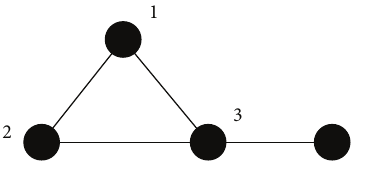
Figure 1: The topology of the four sensors.